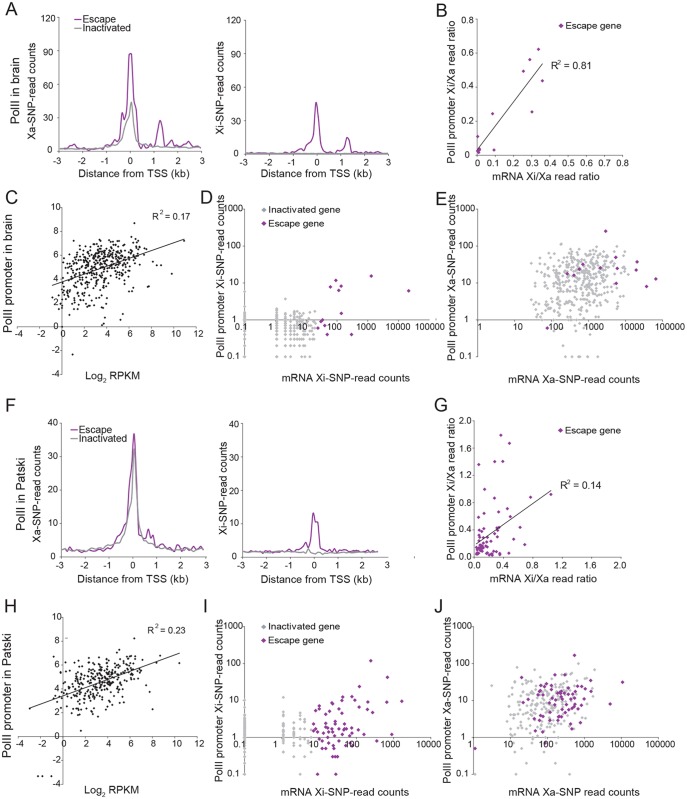
PolII-S5p enrichment at promoters of X-linked genes on the Xi correlates with expression and escape from XCI.(A) Metagene analyses in brain show average Xa- (left) and Xi- (right) SNP read counts in 100bp windows 3kb upstream and downstream of the TSS for escape genes (purple; 14 genes with ≥2 Xi-SRPM in both replicates for brain) and for genes subject to XCI (gray; 403 genes with <2 Xi-SRPM in both replicates for brain). (B) The ratios of PolII-S5p enrichment at the promoter (SNP reads within ±500bp of the TSS) of escape genes (purple) on the Xi versus the Xa are strongly correlated to the ratios of expression from the Xi versus the Xa measured by RNA-seq in brain. Xist is excluded in this analysis. (C) Scatter plot of PolII-S5p promoter enrichment (log2 of reads within ±500bp of the TSS) against expression levels of all X-linked genes (log2 RPKM) shows a positive correlation in brain. (D) Scatter plot of Xi-specific PolII-S5p promoter enrichment (SNP reads within ±500bp of the TSS) against expression (Xi SNP reads) for escape genes (purple) and genes subject to XCI (gray) in brain. Promoter PolII-S5p enrichment correlates with expression from the Xi. (E) Same analysis as for D but for Xa-specific PolII-S5p promoter enrichment in brain. Escape genes generally overlap with genes subject to XCI, but are often highly expressed and enriched in PolII-S5p. (F-J). Same analyses as A-E for Patski cells.